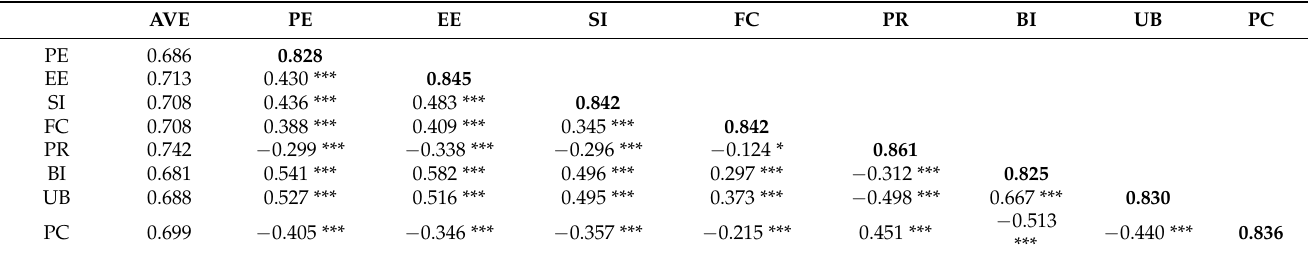
Table 7. Discriminant validity of the measurement model.